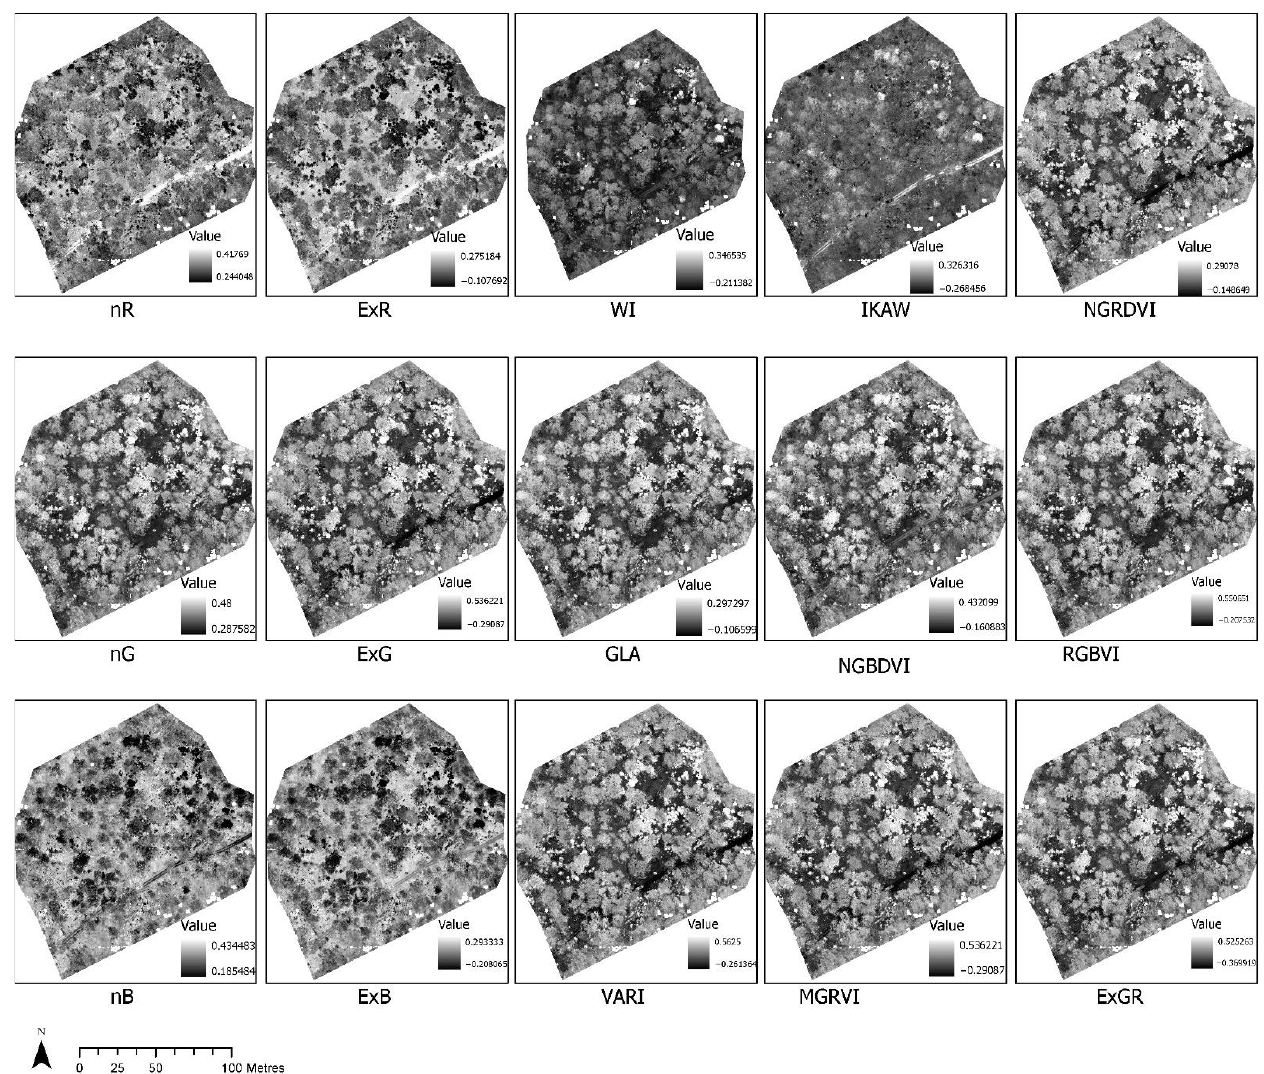
Figure 5. Normalisation of red, green and blue spectrum and calculation of various indices (see Table 2) from normalised bands.